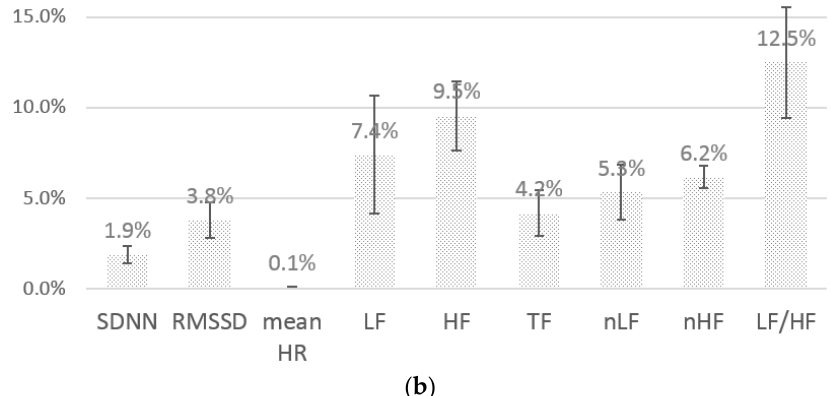
Figure 8. The average error and SDs of the HRV parameters. ( a ) Different use cases; ( b ) different parameters. SDNN, SD of all normal RR intervals; RMSSD, square root of the mean of the squares of the successive differences between adjacent RR intervals; LF, low frequency; HF, high frequency; TF, total spectral power; nLF and nHF, normalized LF and HF.